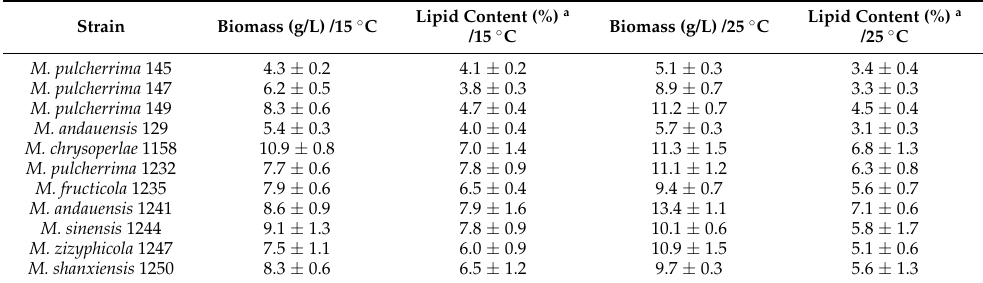
Table 3. Lipids and biomass production at laboratory (25 ◦ C) and cold temperature (15 ◦ C).